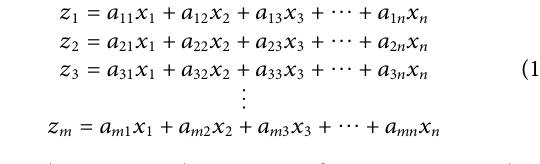
Frontiers in Earth Science |